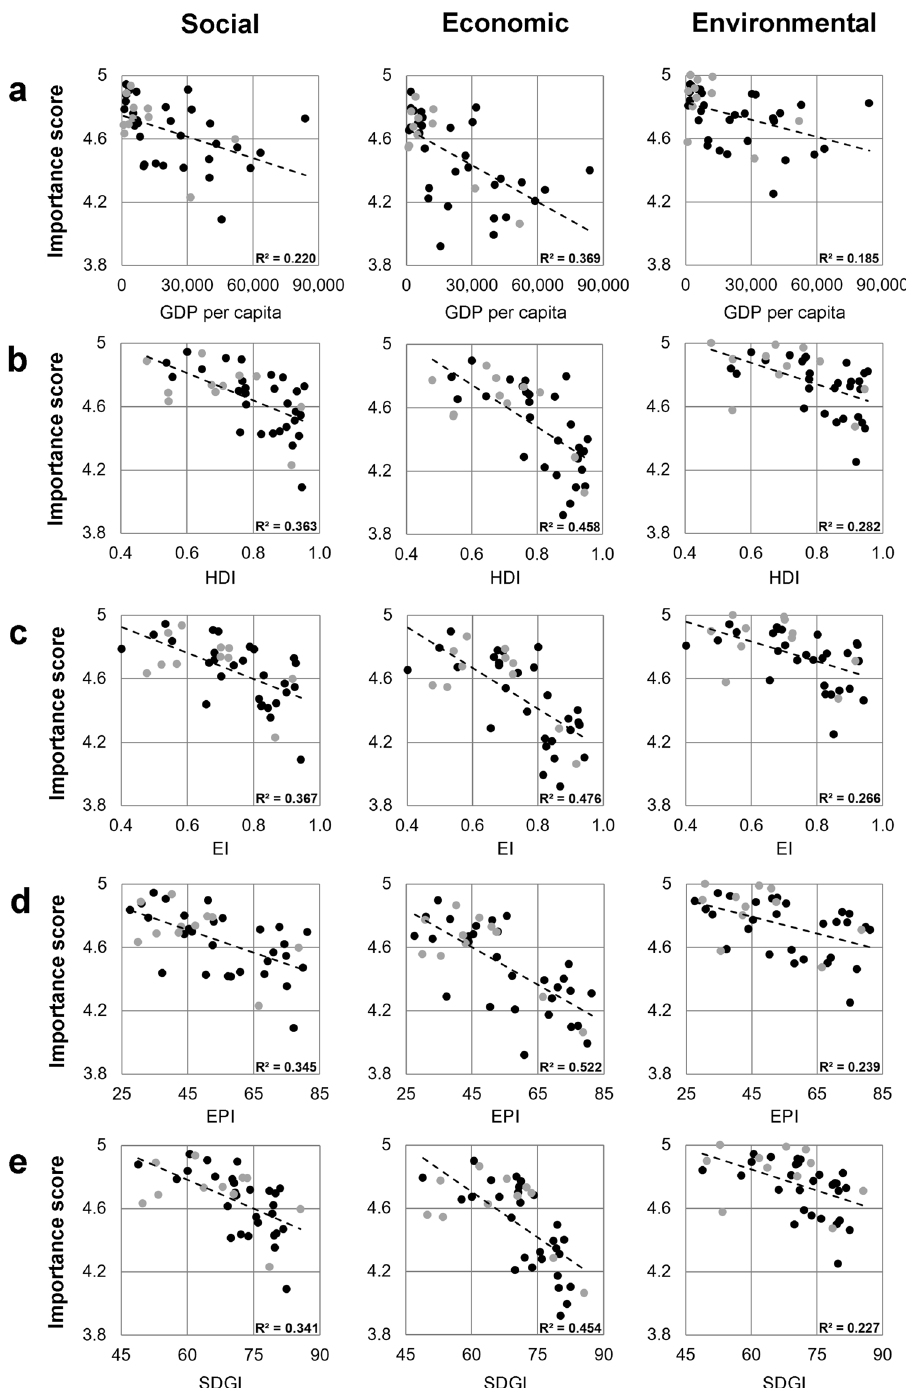
Fig. 2 The mean values of the countries of the assessed importance for the three sustainability factors (social, economic, environmental) plotted against the global development indices examined. Each point represents one country. Countries with fewer than 50 respondents are shown in grey, and countries with more than 50 respondents are shown in black. a Gross domestic product per capita in US dollars, b Human Development Index, c Education Index, d Environment Performance Index, and e SDG